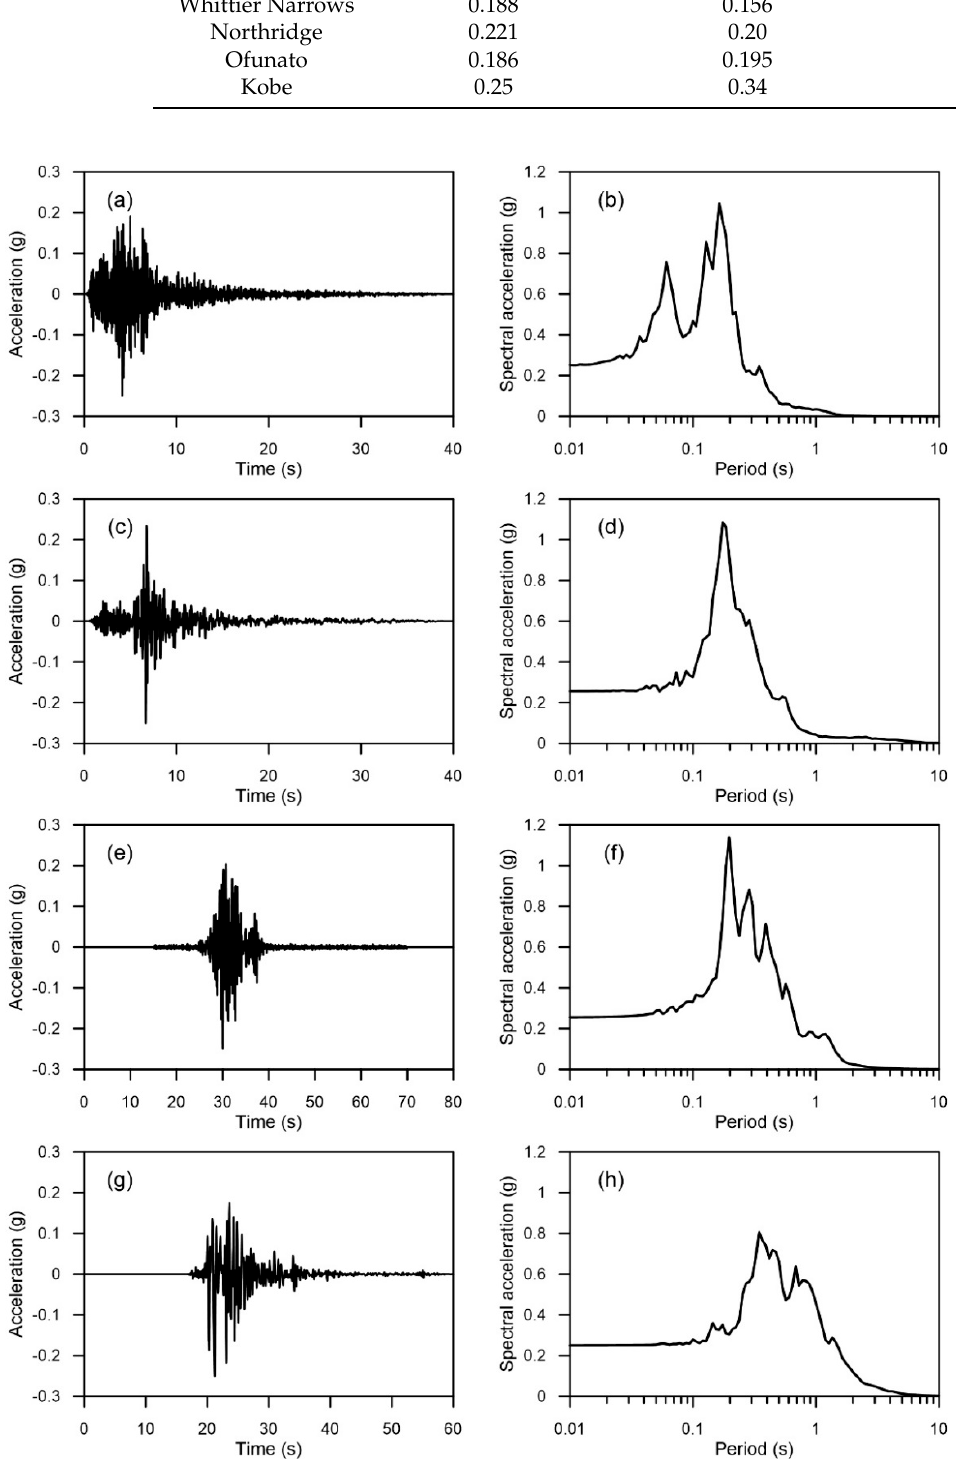
Figure 3. Acceleration time histories and 5% damped response spectra of earthquake ground motions used in the analyses ( a , b ) Whittier Narrows ( c , d ) Northridge ( e , f ) Ofunato ( g , h ) Kobe. Table 2. Characteristics of input ground motions selected for dynamic analyses.